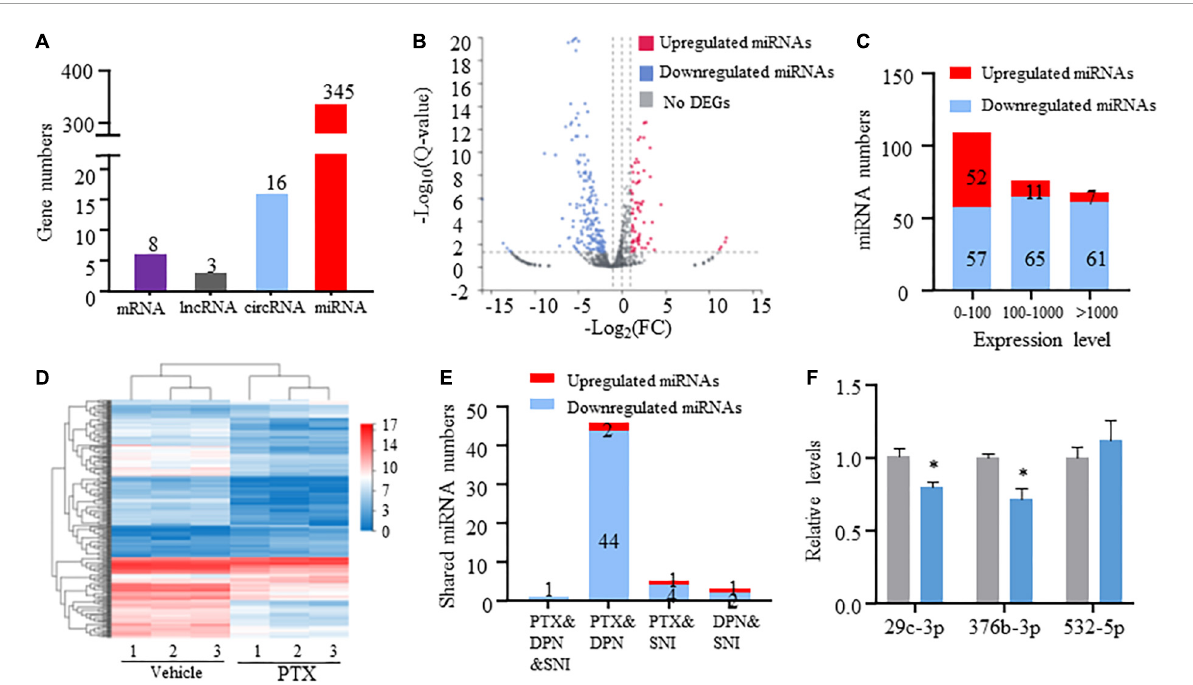
FIGURE2 Transcriptome profiling of miRNAs in paclitaxel (PTX)-treated mice. (A) Numbers of differentially expressed genes (DEGs) were determined using transcriptome analysis. DEGs are genes having Q -values less than 0.05. (B) Volcano plot of differentially expressed miRNAs after PTX administration shows the most highly upregulated [log 2 (fold change, FC) > 1] or downregulated [log2(FC) < − 1] genes. (C) Numbers of upregulated and downregulated miRNA showing low (0–100), medium (100–1,000), or high (more than 1,000) expression levels, based on respective expression level values in the vehicle group. (D) Hierarchical clustering analysis shows 253 differentially expressed miRNAs in vehicle and PTX groups. (E) Numbers of differentially expressed miRNA shared among PTX, diabetic peripheral neuropathy (DPN), and spared nerve injury (SNI) models. (F) Validation of PTX-induced downregulation of miR-376b-3p and miR-29c-3p expression as assessed using quantitative polymerase chain reaction. Results are presented as mean ± SEM of 3–6 independent experiments. ∗ P < 0.05 compared with the vehicle group by two-tailed unpaired t